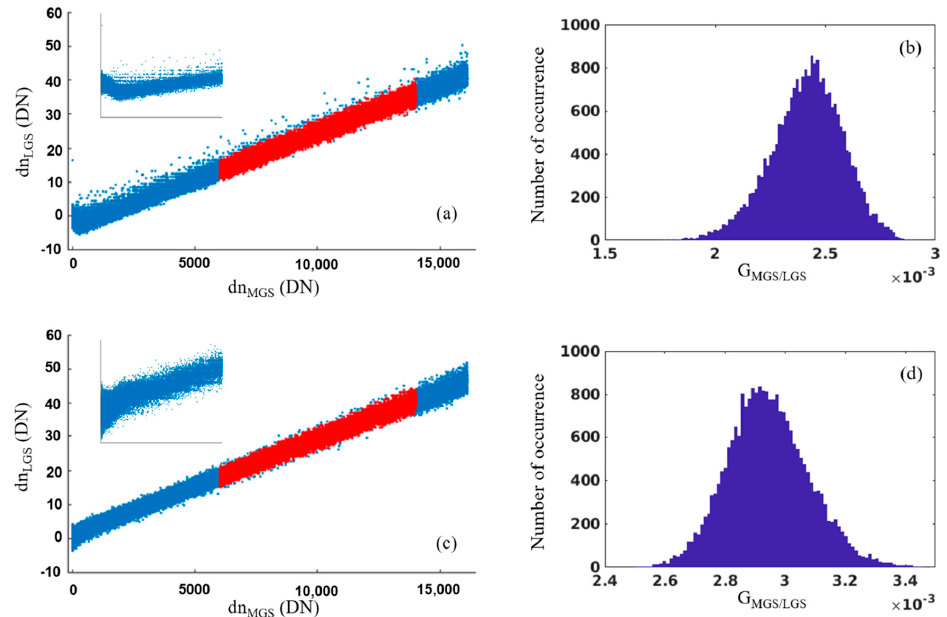
Figure 7. ( a ) Scatter plot of dn LGS and dn MGS collected by a NOAA-20 VROP between 8:38 and 8:54 UTC on 8 October 2018, for aggregation mode 21 and detector 4. The inset shows the data points near the origin. ( b ) Histogram of the gain ratios calculated by the selected pairs of dn LGS and dn MGS [the red part in ( a )] using Equation (6a). ( c ) Scatter plot of dn LGS and dn MGS collected by a NOAA-20 VROP between 8:38 and 8:54 UTC on October 8, 2018, for aggregation mode 21 and detector 6. The inset shows the data points near the origin. ( d ) Histogram of the gain ratios calculated by the selected pairs of dn LGS and dn MGS [the red part in ( c )] using Equation (6a).